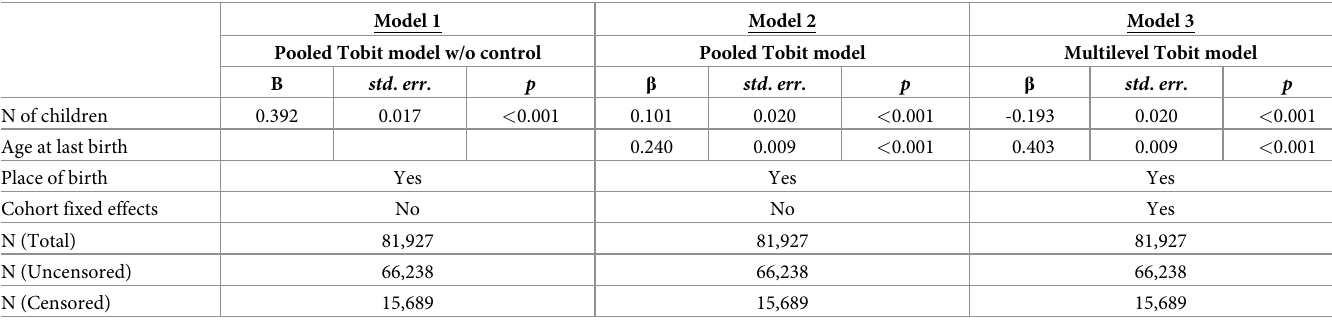
Table 2. Effect of an additional child on maternal lifespan (in